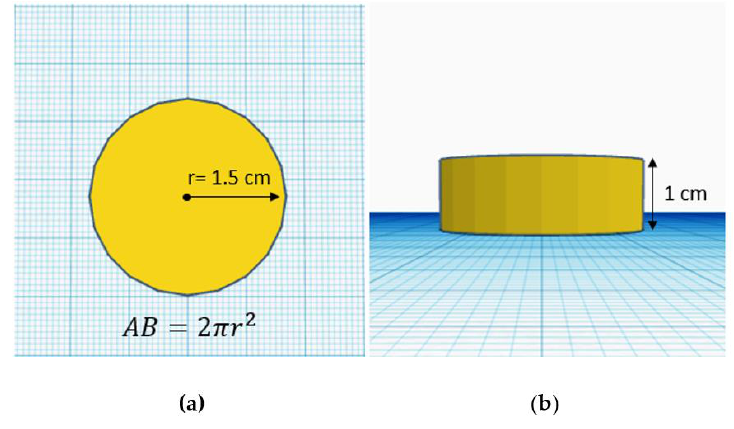
Figure 1. ( a ) Cylinder base area; ( b ) Cylinder height.